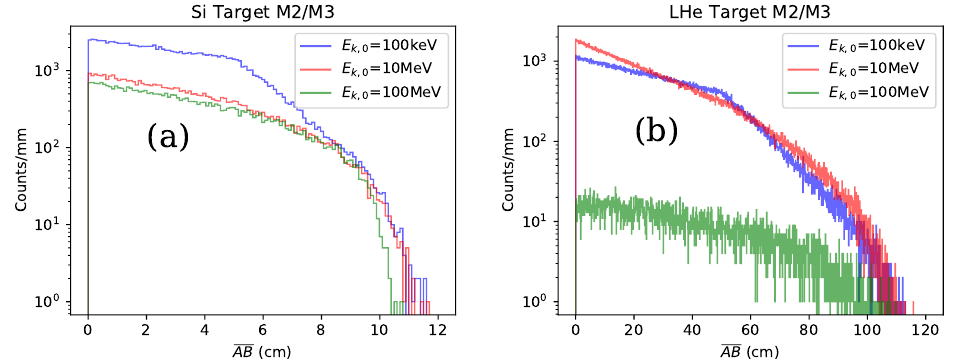
Figure 4. The distribution AB for the M3 in a ( a ) 10 cm 3 Si cube and ( b ) 1 m 3 LHe cube. It shows that a 10 cm Si cube can cover most scattering events.